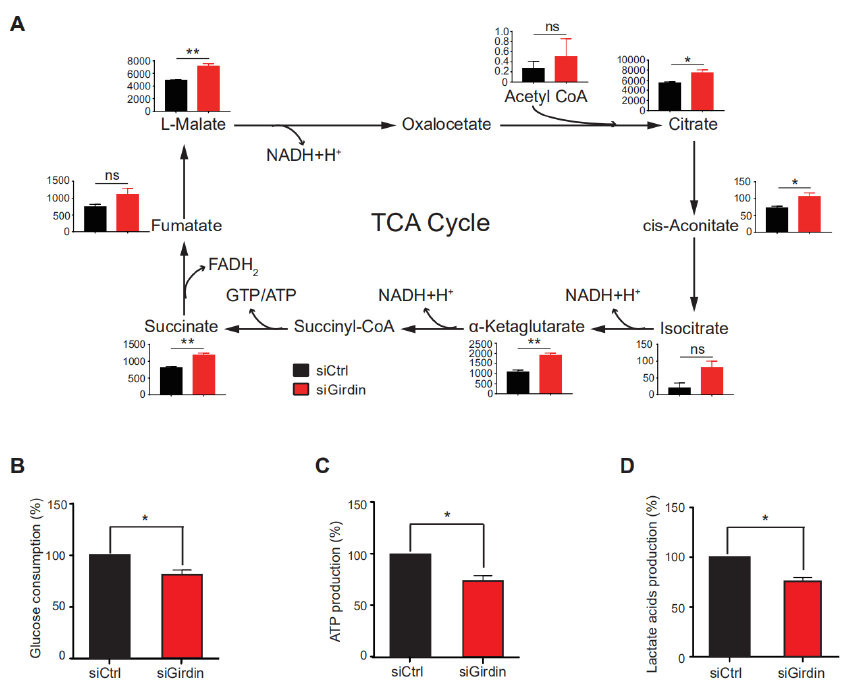
Figure 3. Girdin participates in TCA cycle and glycolysis regulation. ( A ) Metabolomic analysis of cells incubated for 24 hours after transfection with indicated siRNAs for 48 hours and then labeled with D-(13C6) glucose. The amounts of the indicated metabolites of the TCA cycle were measured (ns, not significant, * p < 0.05, ** p < 0.01). ( B ) Glucose consumption in A549 cells transfected with siRNAs (* p < 0.05). ( C ) ATP production in A549 cells transfected with siRNAs (* p < 0.05). ( D ) Lactate acid production in A549 cells transfected with siRNAs (* p < 0.05).